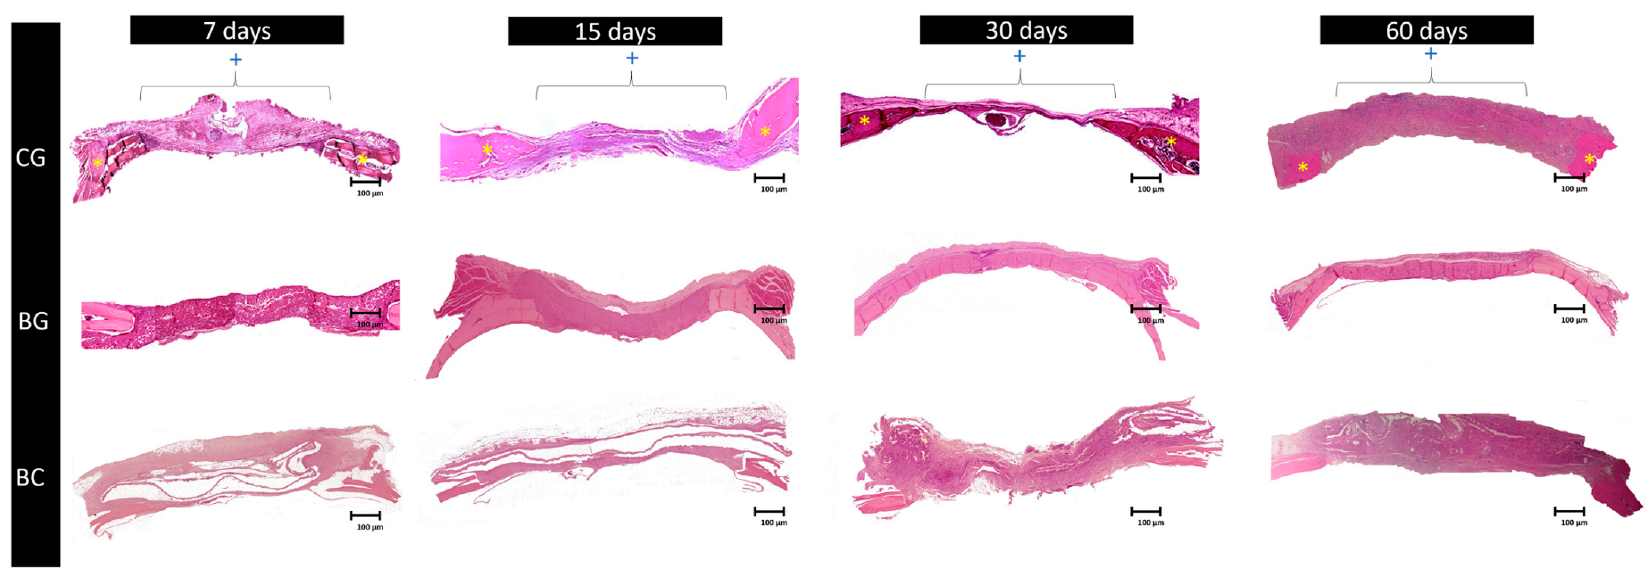
Figure 3. Photomicrographs of the least magnified histological sections ( × 6.3) for the experimental groups (CG: clot group; BG: Bio-Guide ® ; BC: bacterial cellulose) in all periods analyzed (postoperative 7, 15, 30, and 60 days) in which we observed the bone repair capacity of each membrane. The Bio-Guide ® performed better at 60 days with significant closure of the bone defect. The BC group showed good closure of the defect, but with a high prevalence of poorly differentiated connective tissue. * represents regions of the bone stumps; + represents the horizontal extension of the bone defect.